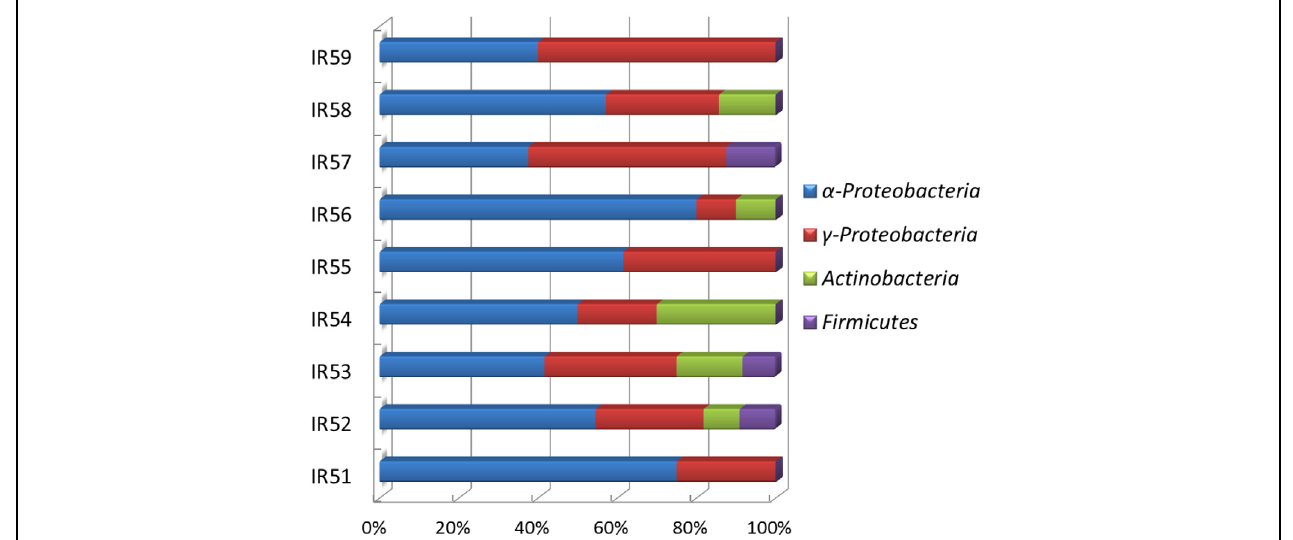
FIGURE 5 | Phylogenetic distributions of bacteria detected by DGGE in nine PAH-degrading